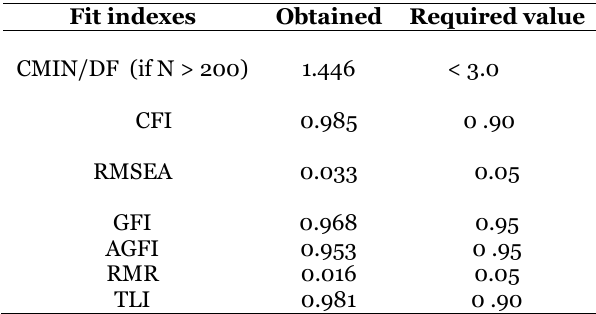
Fit Indexes for the Hypothesized